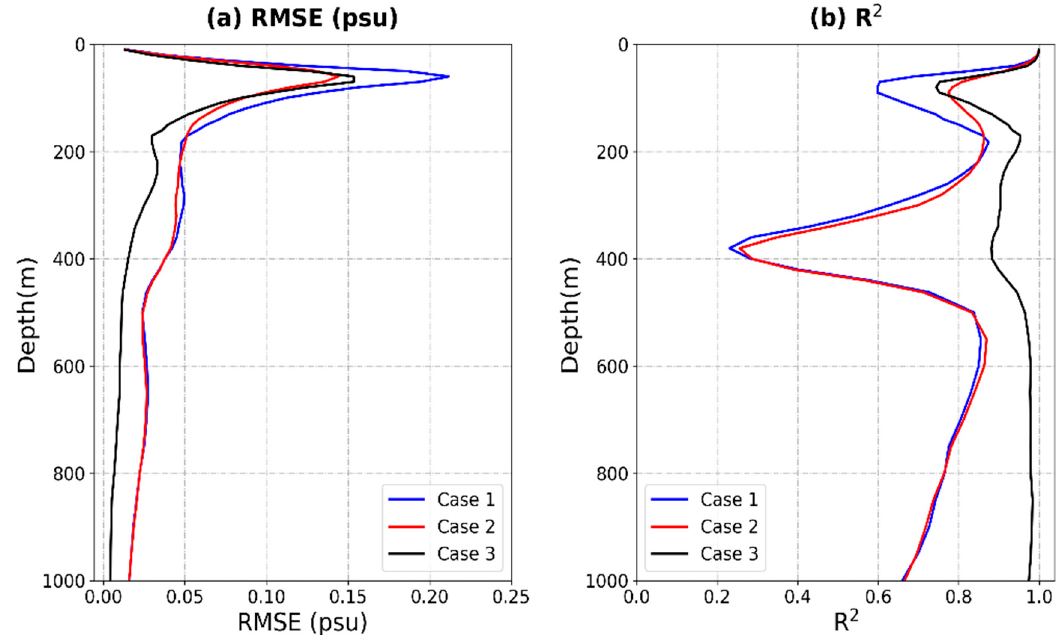
Figure 7. The estimation accuracy of the OSSS at different depths by the LGB-DF model based on ( a ) RMSE (psu) and ( b ) R 2 in different cases in 2019. ( a ) RMSE (psu) and ( b ) R 2 in different cases in